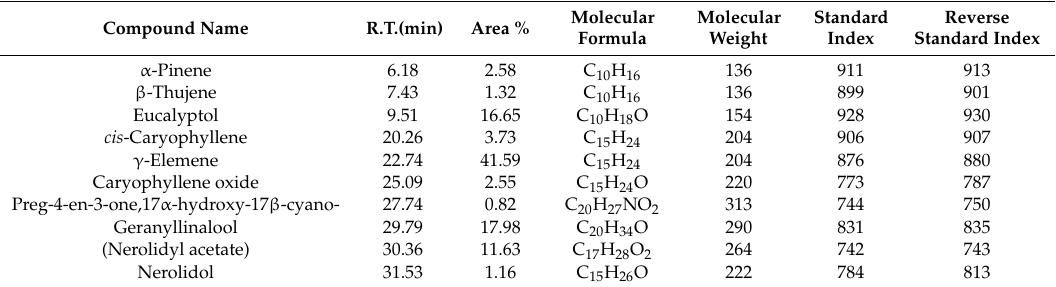
Table 5. Chemical composition of the EOs from V. agnus-castus